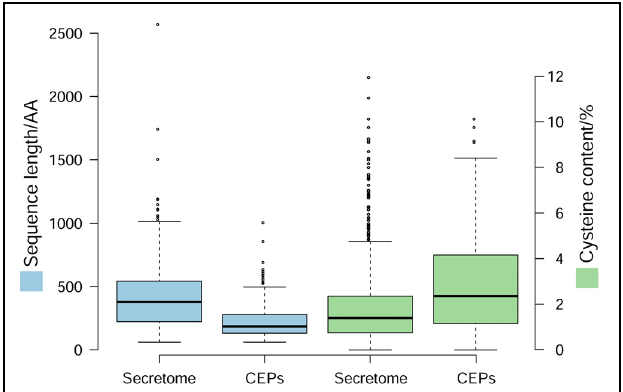
FIGURE 1 | Characteristics of candidate effector proteins (CEPs) in Valsa mali . Box-plot shows sequence length and cysteine content of CEPs compared with those of the total